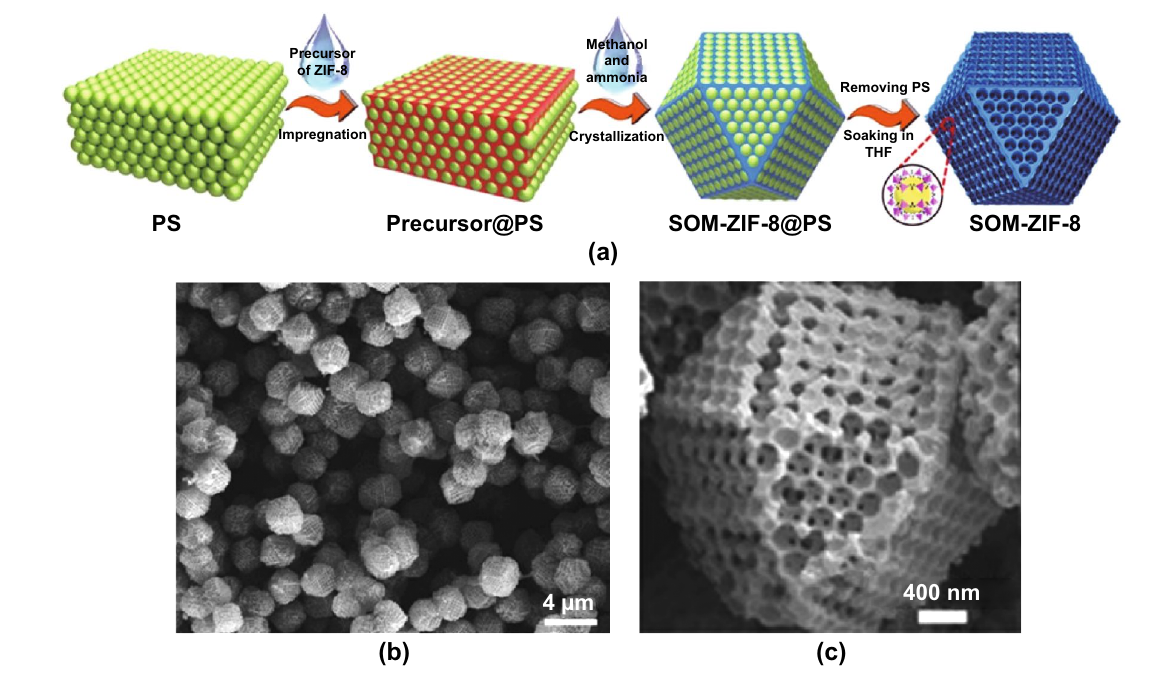
Fig. 9 a Schematic diagram of SOM-ZIF-8 synthesis. SEM images of b SOM-ZIF-8 and c an isolated crystal of SOM-ZIF-8 showing the tetrakaidecahedron morphology. Reprinted with permission from Ref. [69]. Copyright 2018 The Authors, some rights